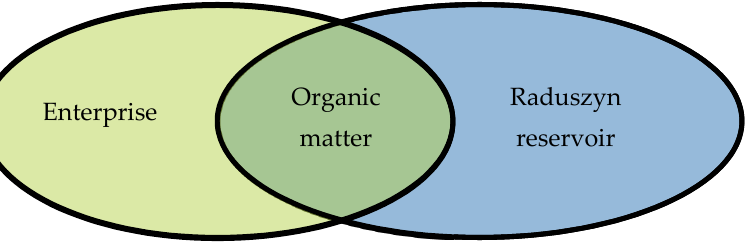
Figure 3. A Venn diagram showing the relationships between the enterprise and the Raduszyn reservoir. The SWOT analysis in this research was conducted in three